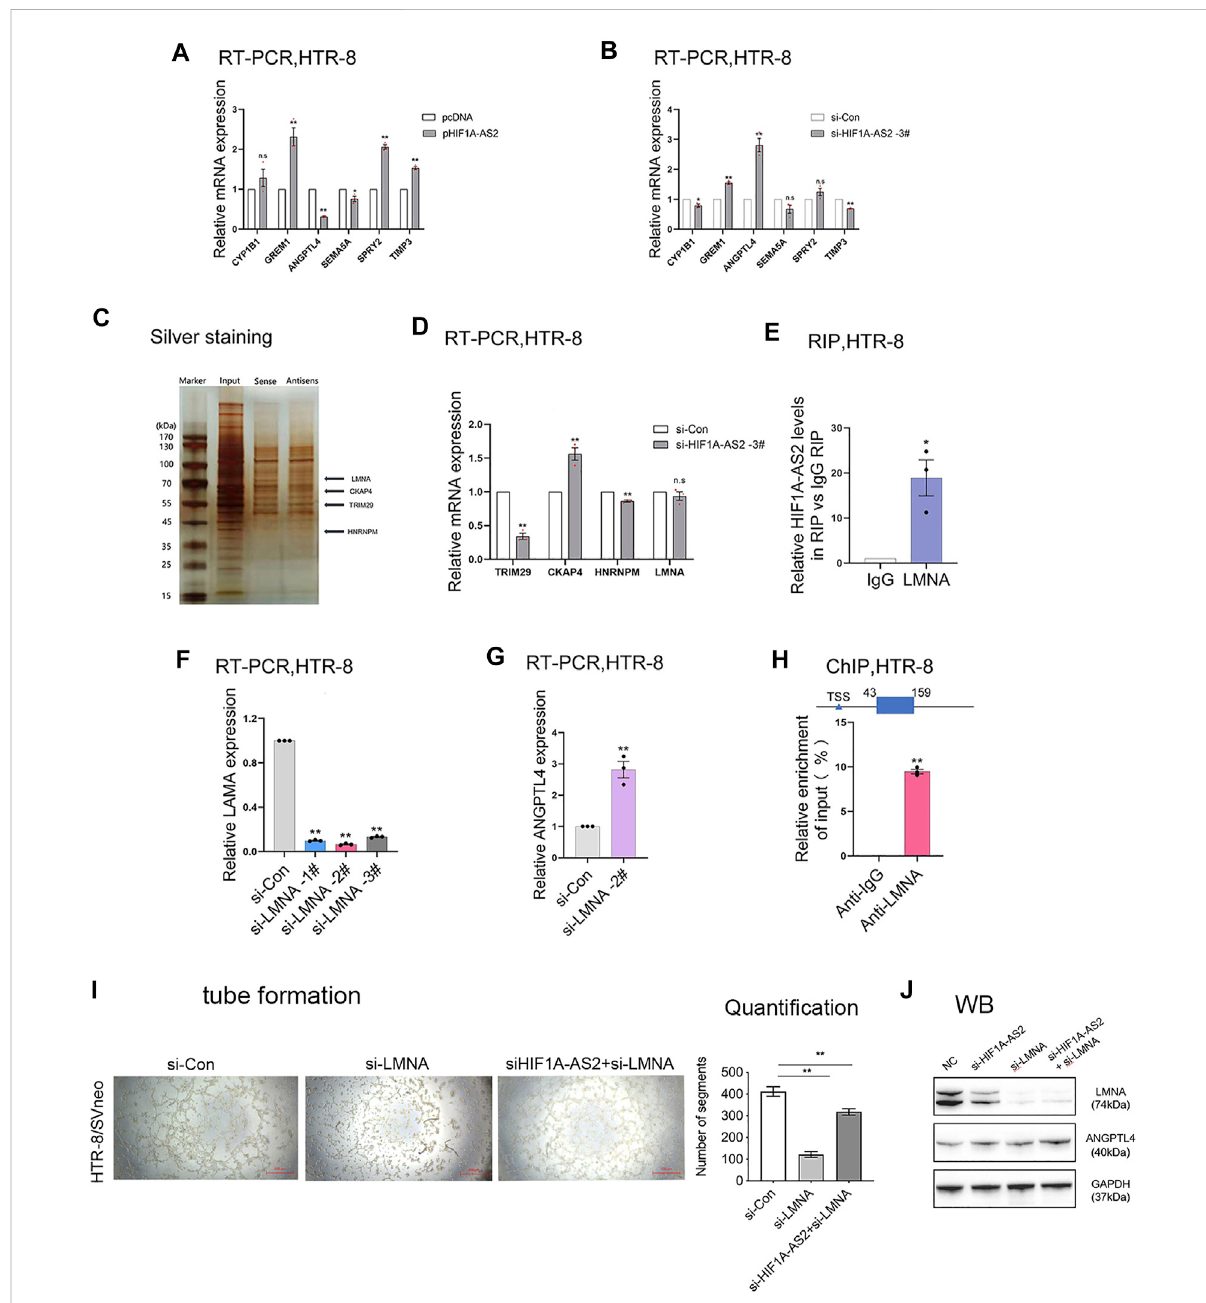
FIGURE 5 HIF1A-AS2 binds to LMNA to inhibit ANGPTL4 expression. qPCR analysis of HTR-8/SVneo cells uncovered the relative mRNA expression of vascularized genes, with (A) HIF1A-AS2 overexpression or (B) knockdown by si HIF1A-AS2 . RNA pull down, silver staining and mass spectrometry analysis werecombined toanalyzeseveralpotential bindingproteins (C) .Aftertransfected withsi HIF1A-AS 2,thechanges inthemRNA expression of several possible binding proteins were analyzed by qPCR (D) . RIP results showed that HIF1A-AS 2 could bind LMNA in HTR-8/SVneo cells (E) . After LMNA knockdown, the expression of ANGPTL4 was increased at RNA levels (F,G) . Error bars are mean with SEM of technical replicates ( n = 3). * p < 0.05,** p < 0.01;signi fi cancebyStudent ’ sttest.ChIPassaysrevealedtheenrichmentofLMNAinANGPTL4promoterregion (H) .Consequentto tube formation, the number of segments and total segments length of the tube were decreased in the inhibition of HIF1A-AS2 and LMNA (I) ; ANGPTL4andLMNAexpressionlevelsweredetectedatproteinlevelbyWBinHTR-8/SVneo (J) .ErrorbarsaremeanwithSEMoftechnicalreplicates ( n = 3). * p < 0.05 and ** p < 0.01; signi fi cance by one-way ANOVA with Tukey post-test. All data are representative of at least two independent